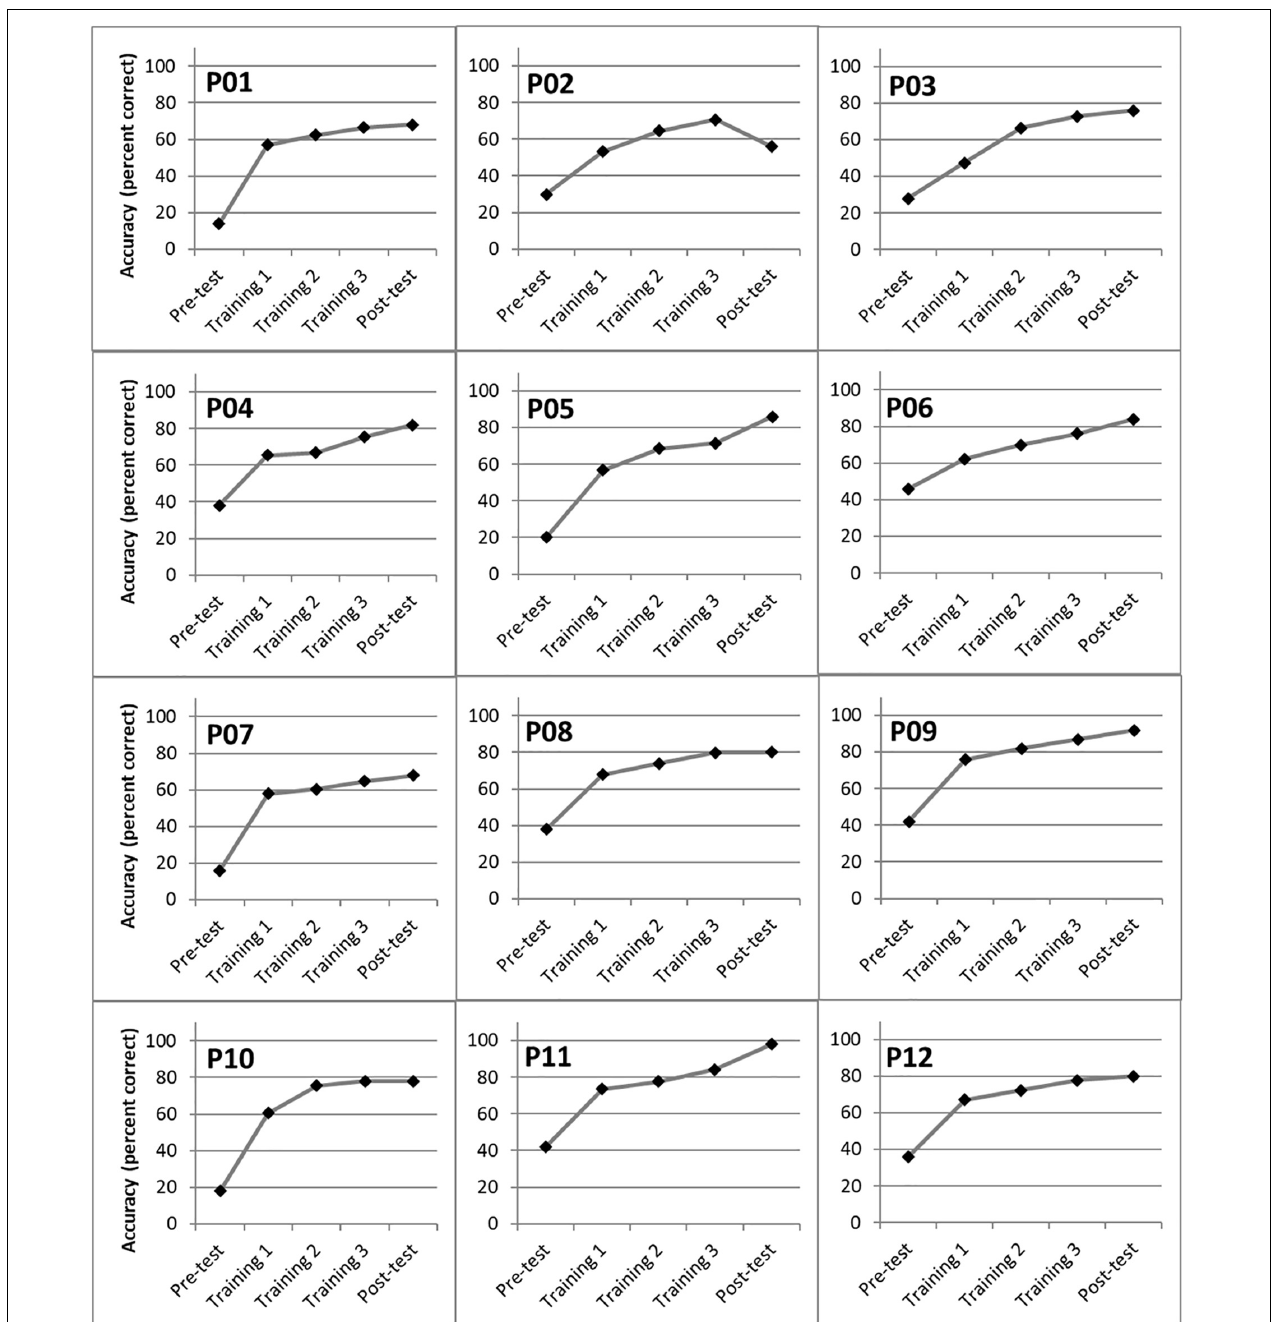
FIGURE 4 | Word identification accuracy for individual members of the training group at the pre-training test (“pre-test”), Training Session 1, Training Session 2 Training Session 3, and at the post-training test (“post-test”), for the babble-noise conditions